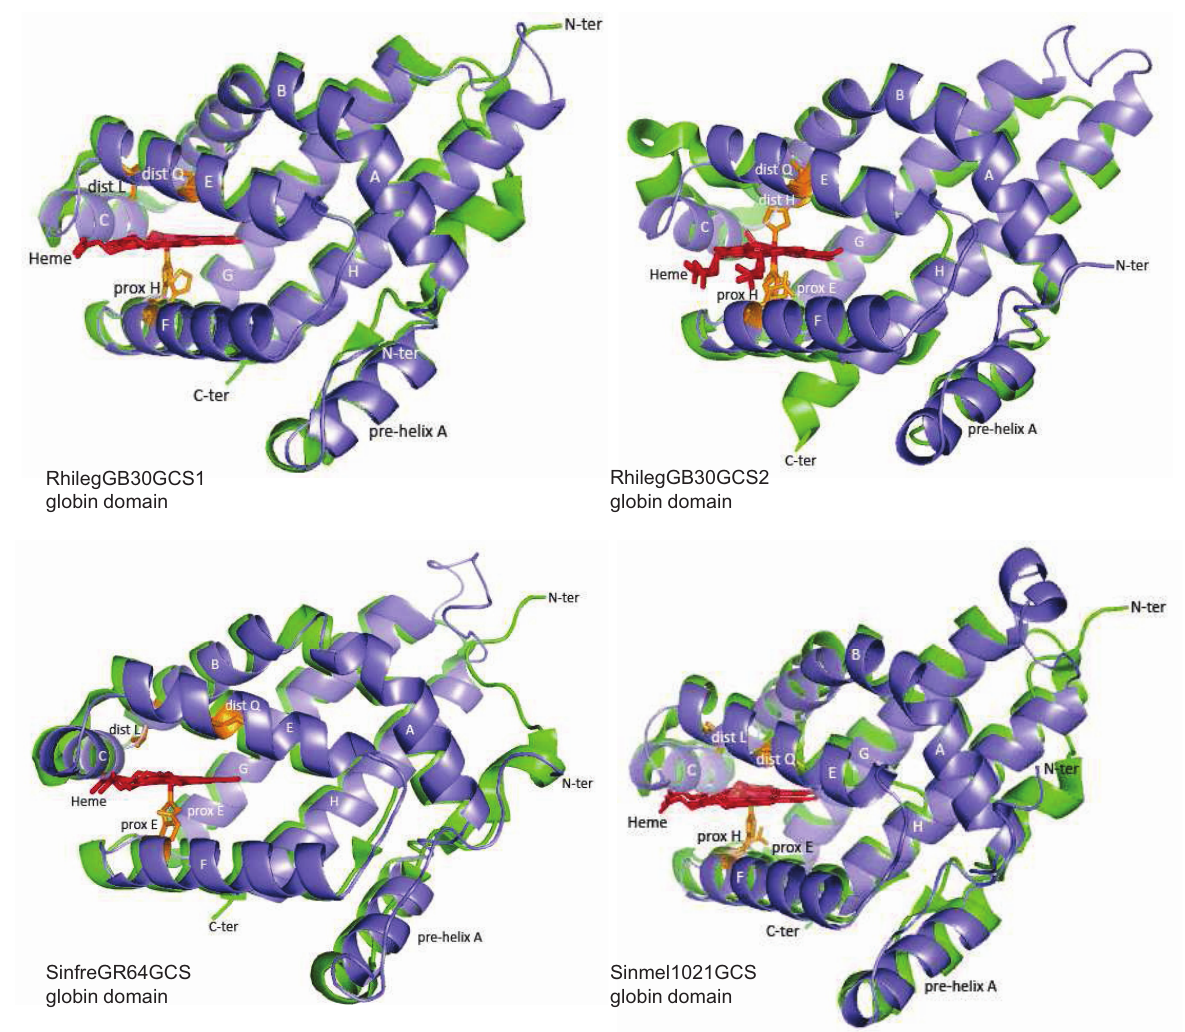
Figure 5. Predicted structure of selected rhizobial GCSs globin domain (blue) overlapped to structural homologues (green). Structural homologues are indicated in Dataset 3. Distal and proximal amino acids to the heme Fe are shown in brown. Heme is shown in red. Helices are indicated with letters A to H. All structures are displayed in the same orientation.